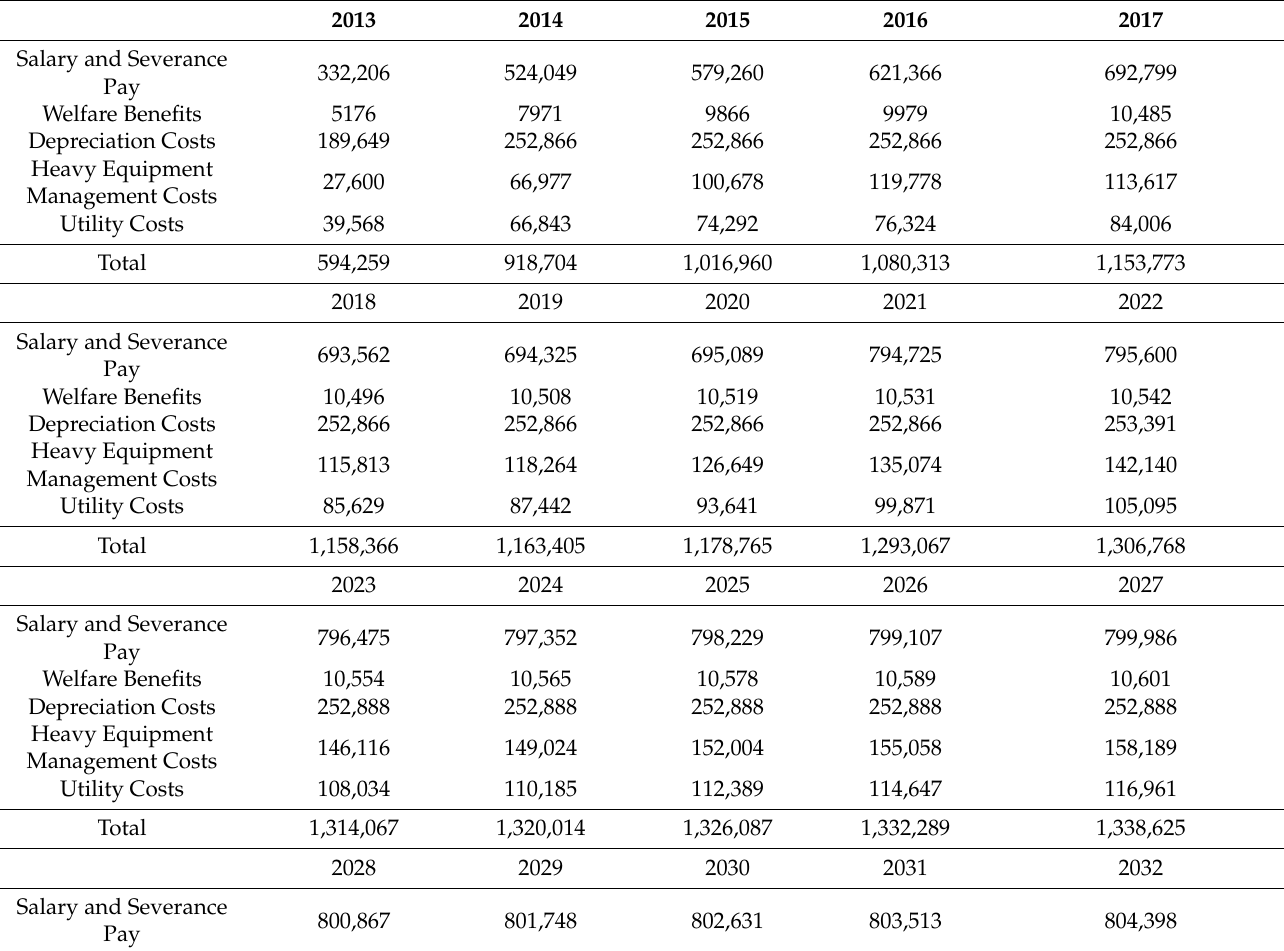
Table 8. Estimated total cost of sales for 30 years (unit: U.S.